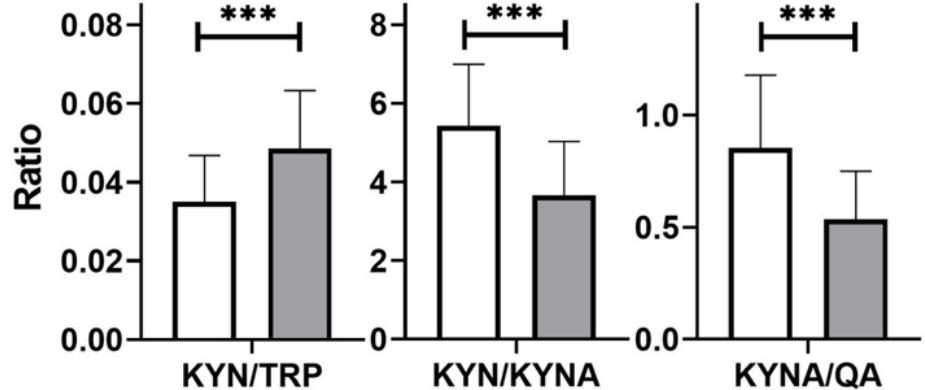
Figure 3. Ratios of tryptophan (TRP) and its metabolite levels (mg/gCr): kynurenine (KYN), kynurenic acid (KYNA), and quinolinic acid (QA) in healthy subjects (white) and in patients with small intestinal bacterial overgrowth (grey); differences between groups were analyzed using the Mann–Whitney U test; n = 40, *** p < 0.001.